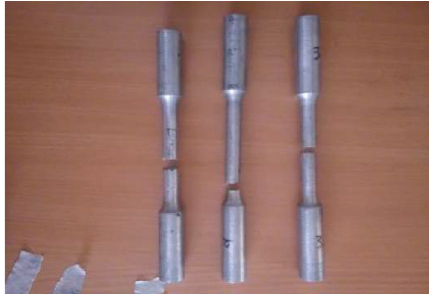
Figure 3: Test specimen (after test). Table 5: Tensile